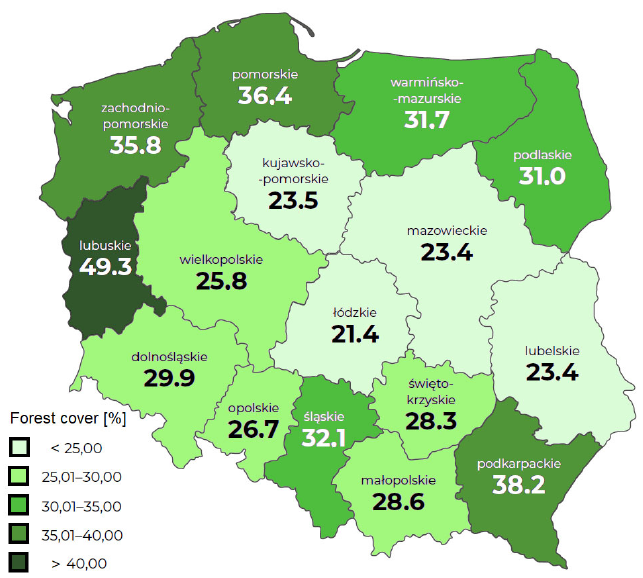
Figure 4. Forest cover of voivodships in Poland (2020) (source: [46], modified). Low forest cover should therefore be a priority indication for further afforestation.